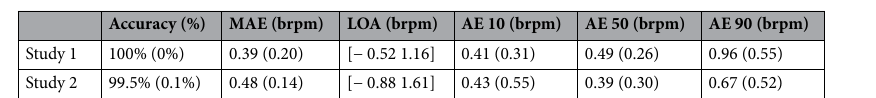
Table 3. Summary of instantaneous and statistic breathing rate